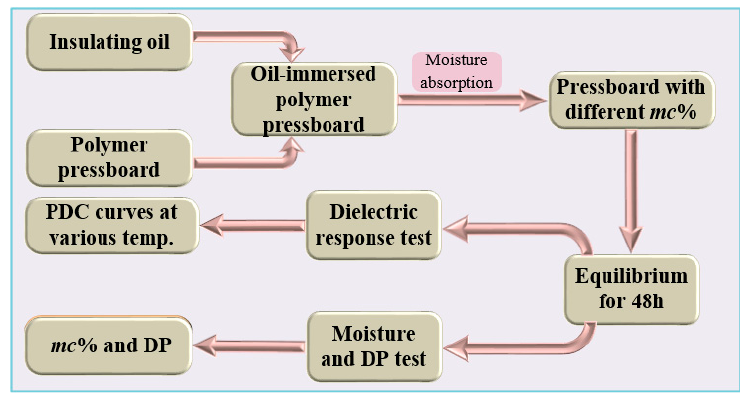
Figure 1. The preparation and testing process of samples.